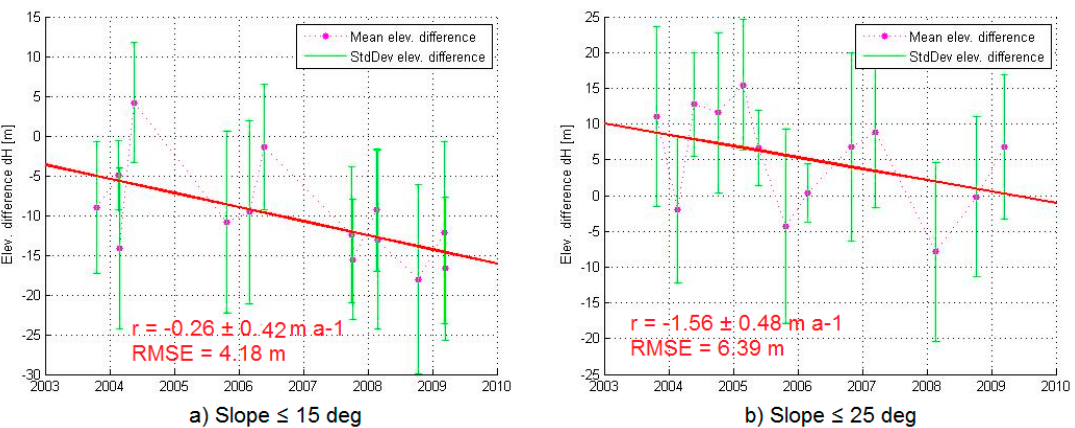
Figure 9. Estimations of glacial thickness change trends with varying slope S 0 thresholds: ( a ) 15 ◦ ; and ( b ) 25 ◦ at a glaciated area (No. 6 in Table S1) in the Hengduan Mountains, belonging to the Brahmaputra Basin. In this example the roughness R 0 was kept fixed at 15 m.